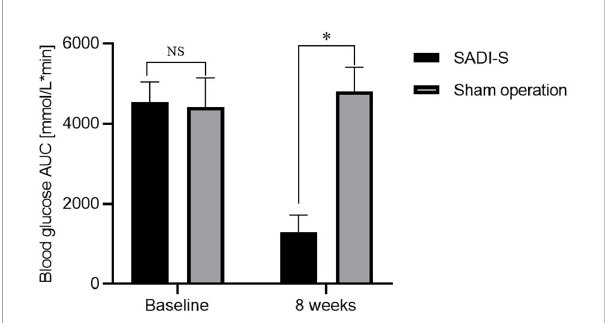
FIGURE 1B Changes in blood glucose AUC during IPGTT before and after surgery. NS indicates no signi fi cant difference between the SADI-S group and sham operation group. * represents a signi fi cant difference between the SADI-S group and sham operation group (P<